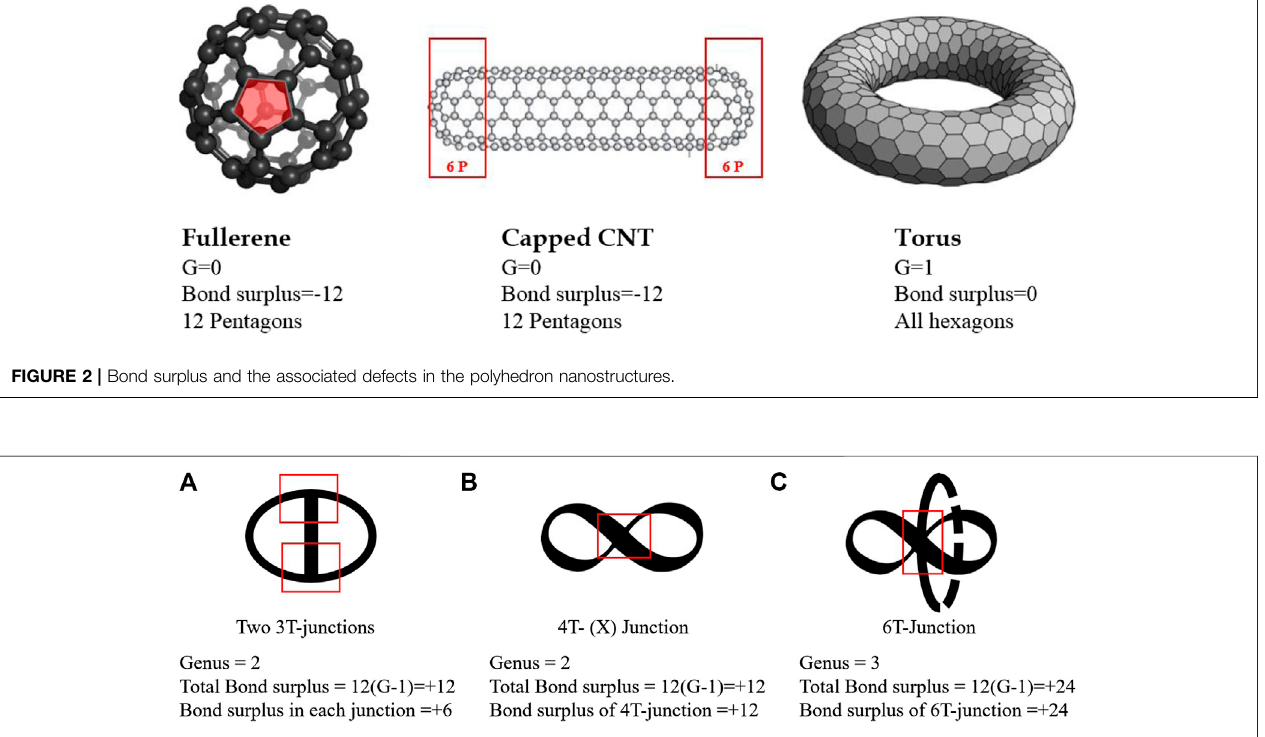
FIGURE 3 | Schematic to determine the genus and bond surplus of geometrical fi gures of (A) 3T-junction (B) 4T-junction and (C) 6T-Junction.